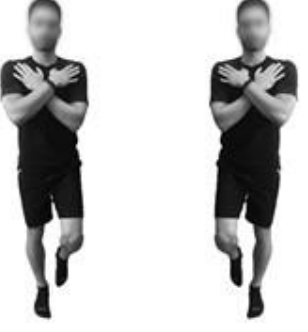
Figure 1. One-leg test